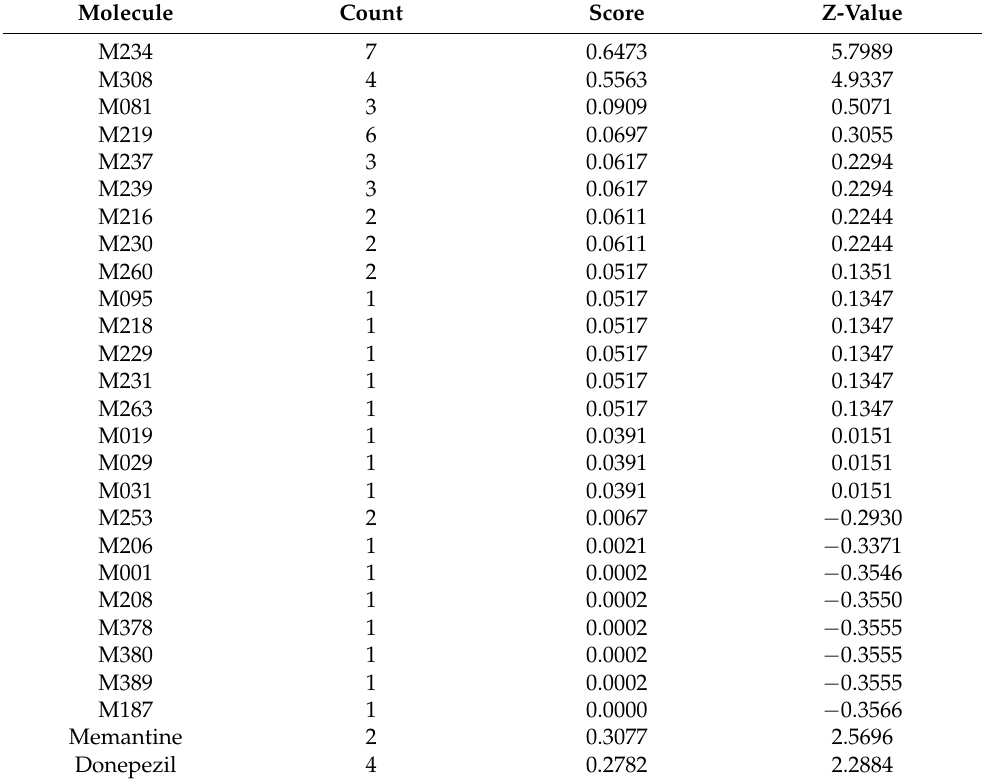
Table 2. Network scores of anti-AD